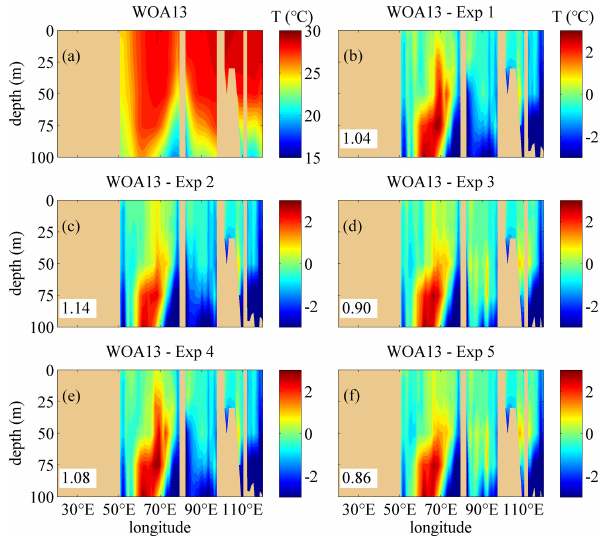
Figure 7. The same as Fig. 4, but along 7.5 ◦ N and in